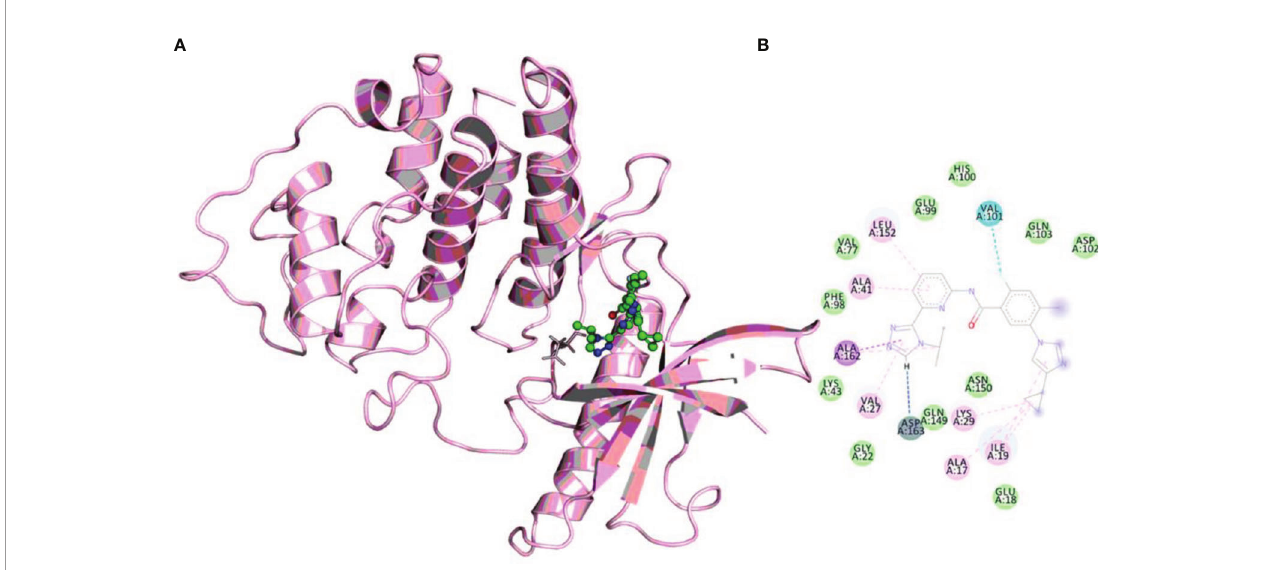
FIGURE 1 | (A) The docked complex of selonsertib within the active site of CDK6. (B) Showing interactions of active site residues of CDK6 with the